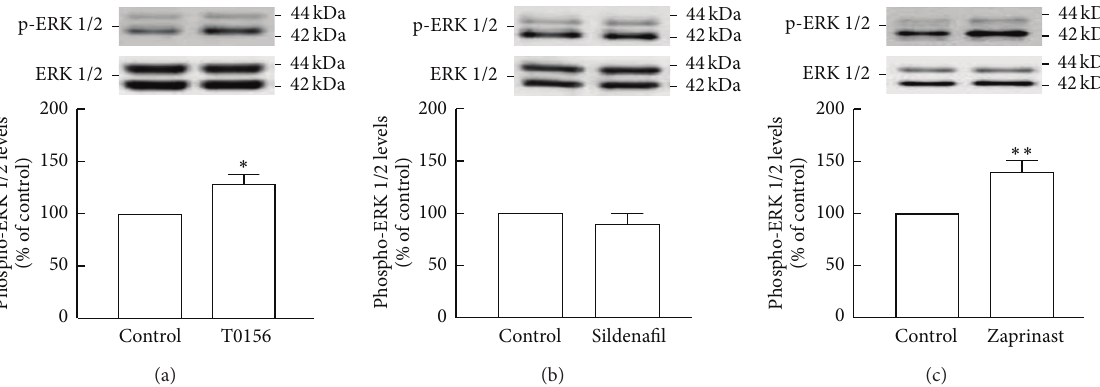
Figure 3: T0156 or zaprinast, but not sildenafil, increased ERK1/2 phosphorylation following 2h of treatment. Phospho-ERK1/2 levels following treatment with 1 𝜇 M T0156 (a), 1 𝜇 M sildenafil (b), and 10 𝜇 M zaprinast (c) for 2h were assessed by Western blot. Representative images are shown. Data are expressed as means ± SEM of at least 5 independent experiments. Two-tailed 𝑡 -test, ∗ 𝑃 < 0.05 and ∗∗ 𝑃 < 0.01 , significantly different from